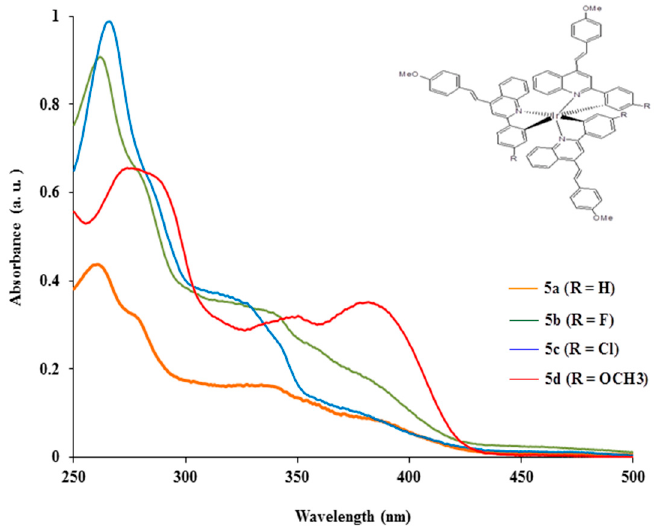
Figure 6. UV-Vis Absorption spectral of Ir(III) complexes of 5a – d in methanol (concentration 1.0 × 10 − 3 mol/L).